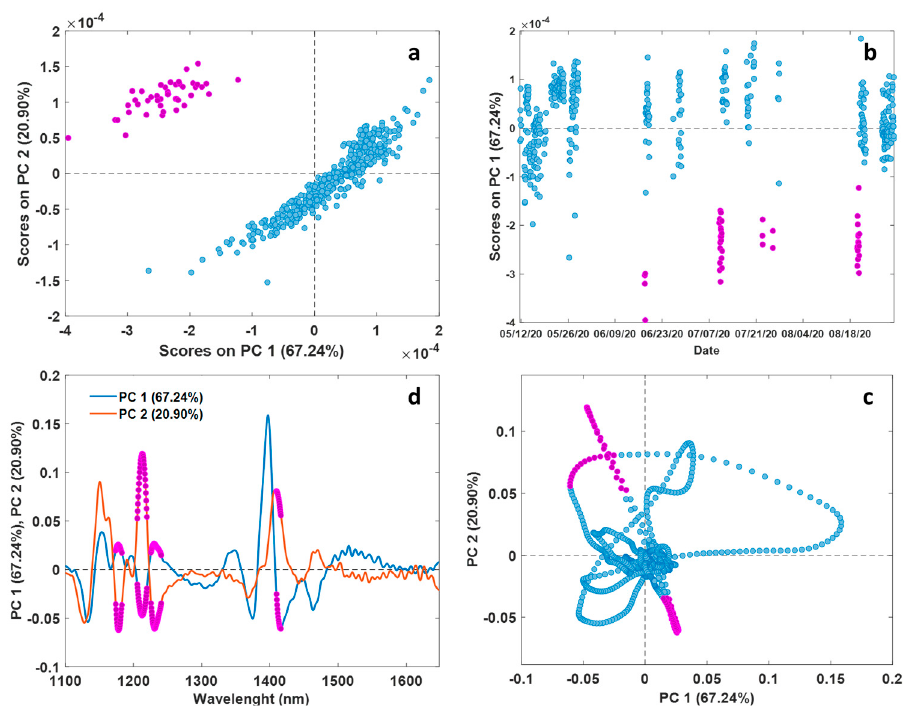
Figure 2. Results of the Exploratory Data Analysis performed on NIR data. PC1 vs. PC2 Scores plot ( a ), Scores on PC1 as a function of time ( b ), Loadings on PC1 and PC2 as a function of time ( c ), and Loadings on PC1 vs. PC2 ( d ). In ( a , b ), purple points represent anomalous samples; in ( c , d ), purple points represent wavelengths that mainly depict the difference of anomalous samples from the other ones.